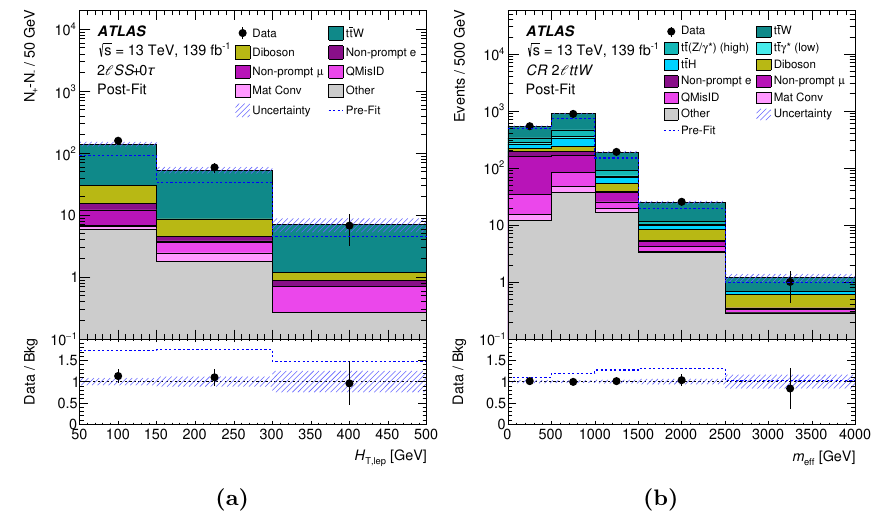
Figure 6. (a) Comparison between data and the background prediction for the distribution of the scalar sum of the lepton p ( H ) in the 2 ‘ SS+0 τ channel, obtained by subtracting the T T, lep corresponding distributions for events with positive and negative total charge. In (b) the comparison is performed for the m distribution in the 2 ‘ ttW CR without splitting according to total charge. eff The background contributions after the likelihood fit to data (“Post-Fit”) under the background-only hypothesis are shown as filled histograms. The total background prediction before the likelihood fit to data (“Pre-Fit”) is shown as a dashed blue histogram in the upper panel. The ratio of the data to the background (“Bkg”) prediction is shown in the lower panel, separately for post-fit background (black points) and pre-fit background (dashed blue line). The size of the combined statistical and systematic uncertainty in the background prediction is indicated by the blue hatched band. The last bin in each figure contains the